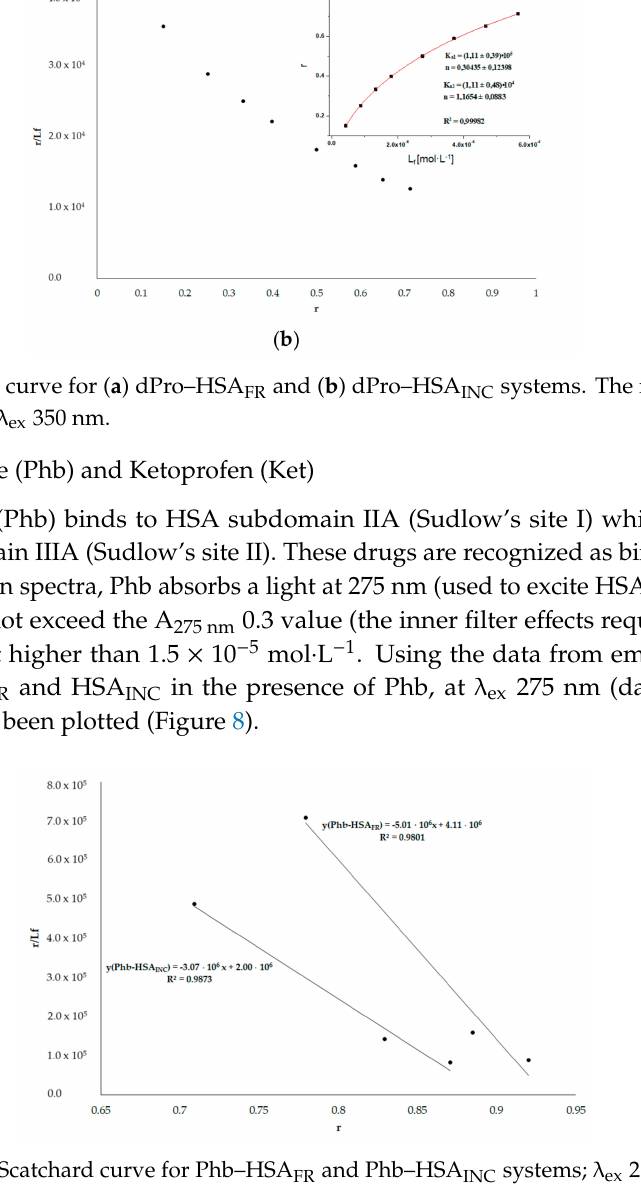
Figure 8. Scatchard curve for Phb–HSA FR and Phb–HSA INC systems; λ ex 275